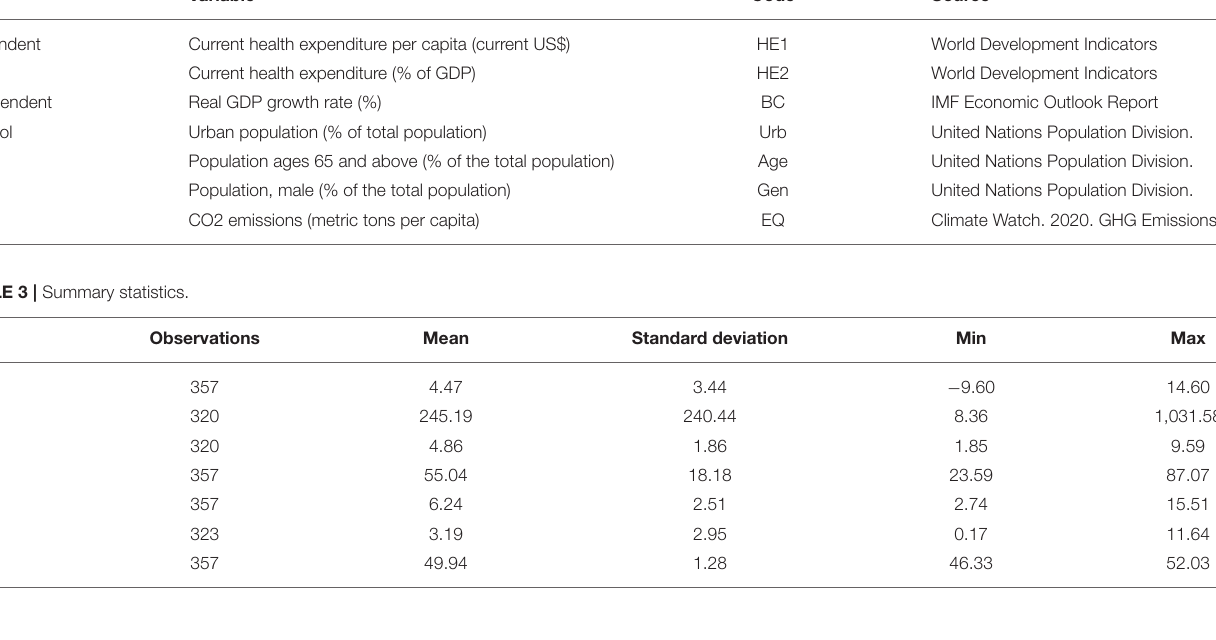
TABLE 4 | Unit-root